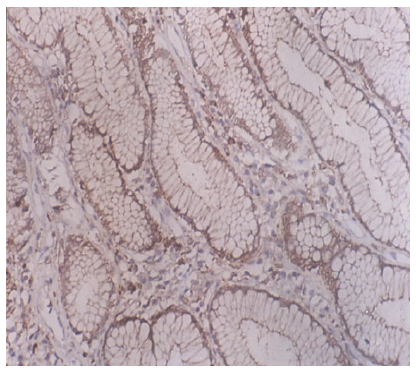
Figure 1. A. Strong positive expression of CD40 in gastric cancer tissues; B. Negative expression of CD40 in normal tissues around tumor. C. Weak positive expression of CD138 in gastric cancer tissues; D. Positive expression of CD138 in normal tissues around tumor; E. Negative expression of Gelsolin in gastric cancer tissues; F. Strong positive expression of Gelsolin in normal tissues around tumor; G. Positive expression of P53 in gastric cancer tissues; H. Negative expression of P53 in normal tissues around tumor; I. Positive expression of P65 in gastric cancer tissues; J. Negative expression of P65 in normal tissues around